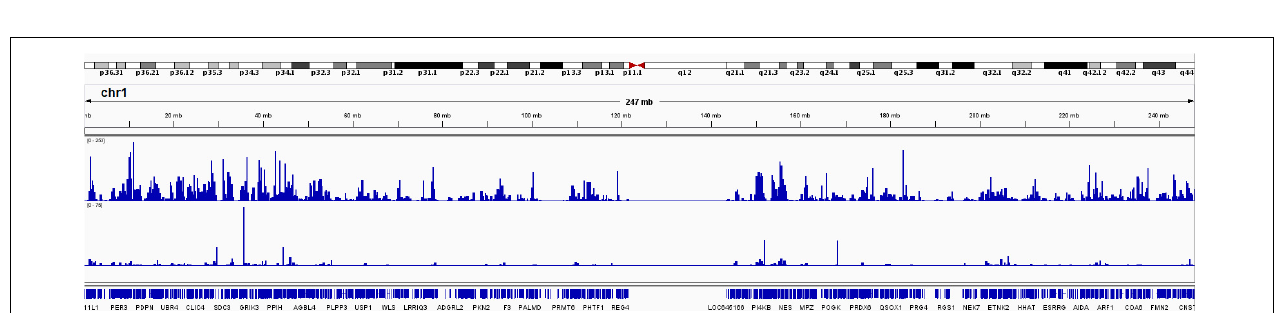
Frontiers in Genetics |